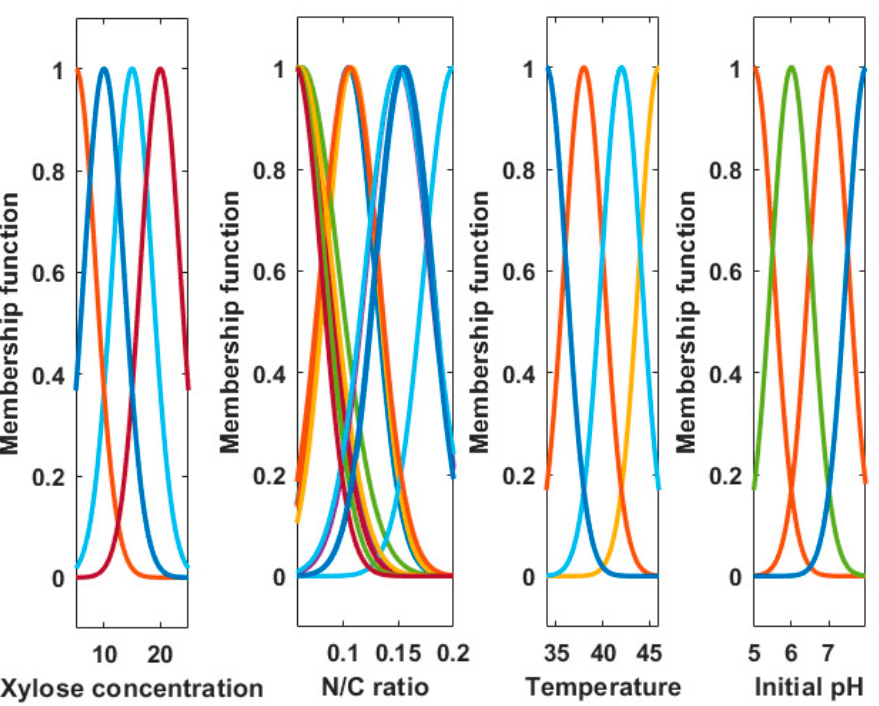
Figure 3. The membership functions of the ANFIS model.